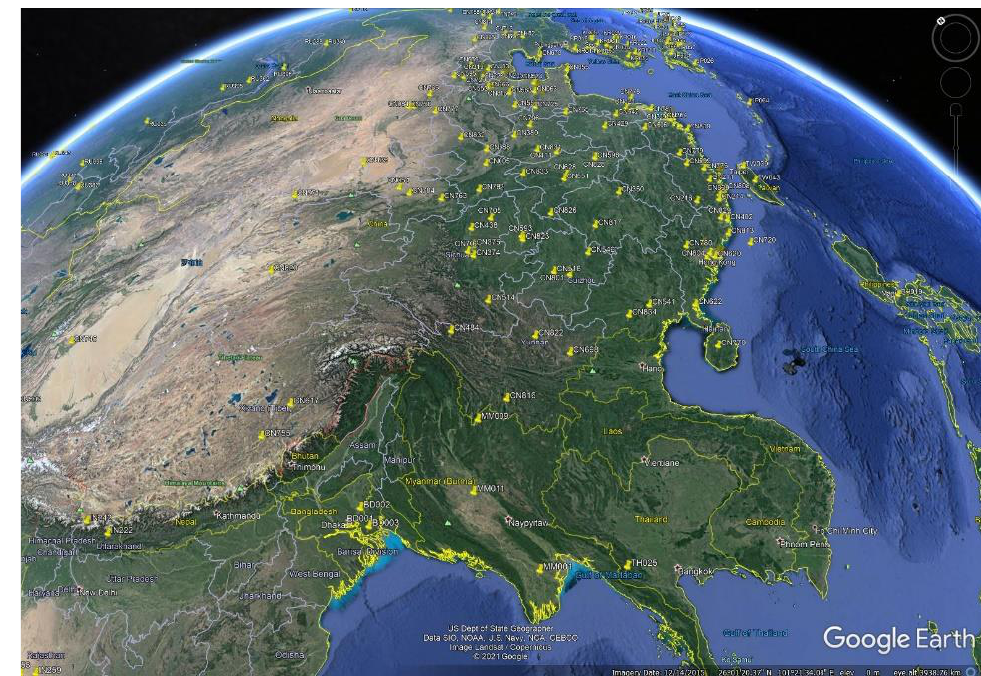
Figure 12. Google Earth pins.